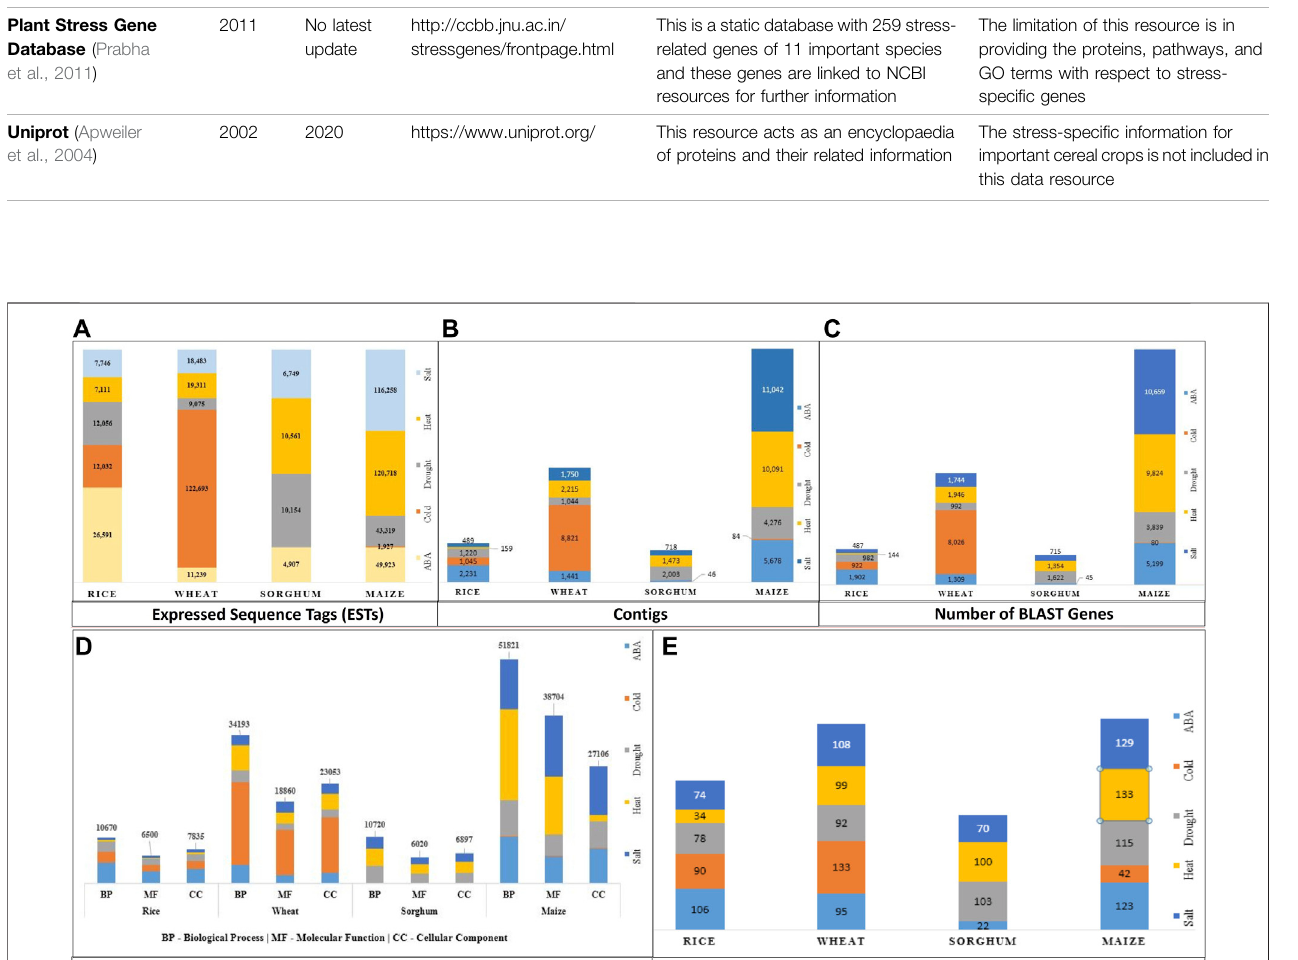
Frontiers in Genetics |